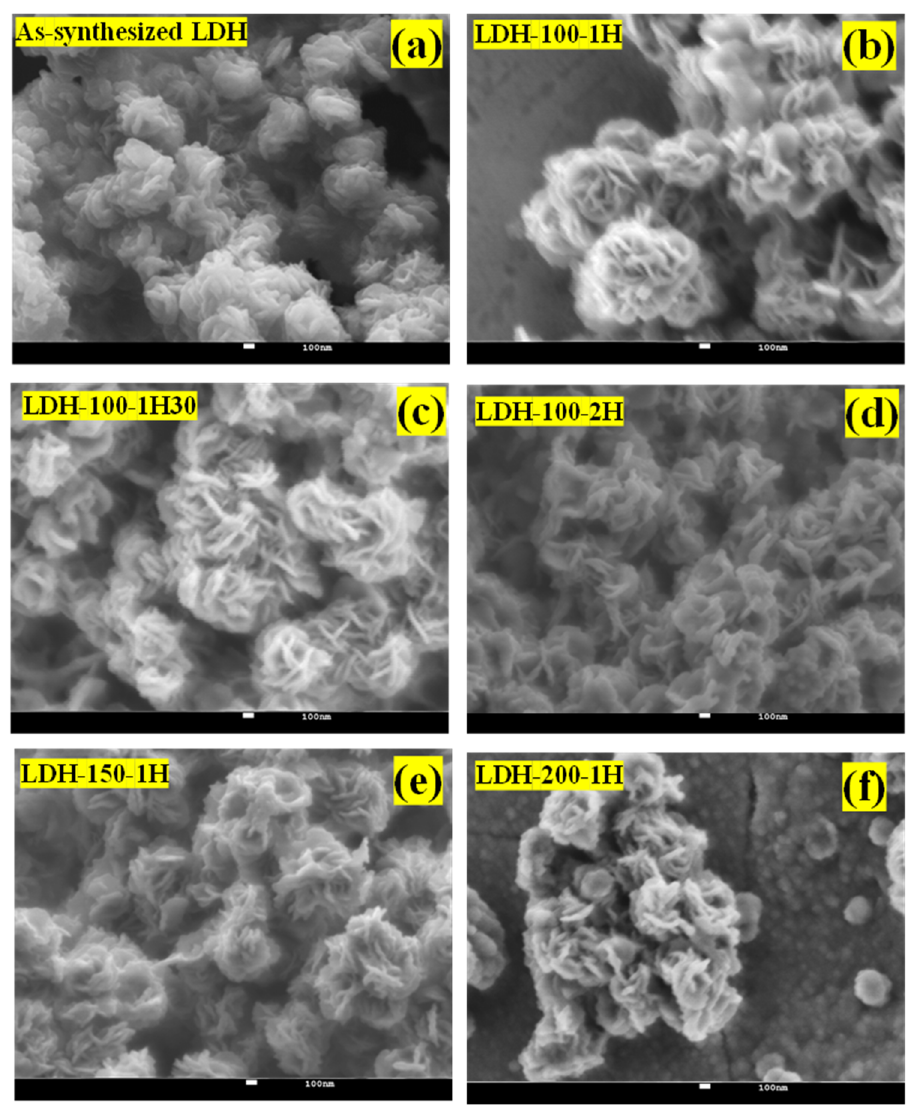
Figure 3. FESEM images of ( a ) the as-synthesized LDH used as electrode active material; ( b – f ) the LDH-100-1h, LDH-100-1h30, LDH-100-2h, LDH-150-1h, and LDH-200-1h electrodes.